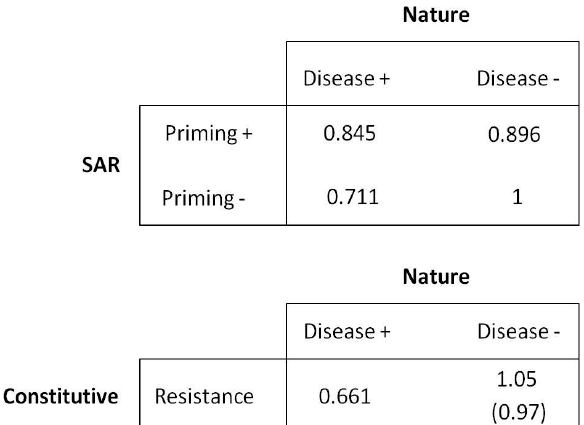
Figure 1. Payoff matrices showing fitness values for two two-player games versus Nature involving hypothetical populations of plants under two scenarios of systemic acquired resistance (SAR) and constitutive resistance (CON) strategies. SAR competes against Nature in the first game using one of two strategies (priming + or priming -), while CON competes against Nature using only constitutive resistance as a strategy. In one scenario strategies are complementary, and the SAR population has constitutive resistance as well as the capability for induced resistance. In the alternative scenario (parentheses), one population has SAR alone and one population has CON alone. The populations may be either primed for resistance or unprimed, and they may be either healthy or subjected to a disease epidemic. The constitutive population is unaffected by priming.